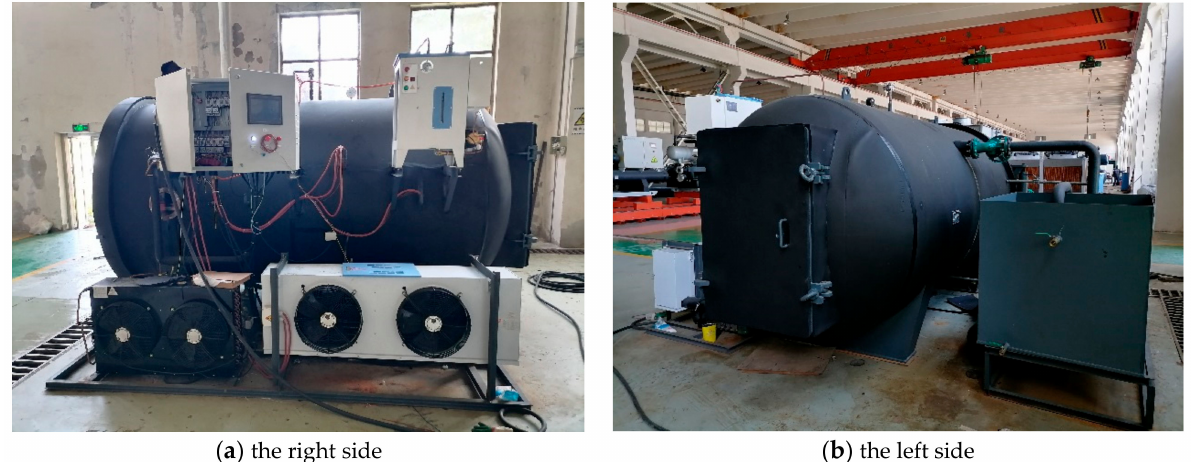
Figure 2. The assembled drying system with combined LPSSD and